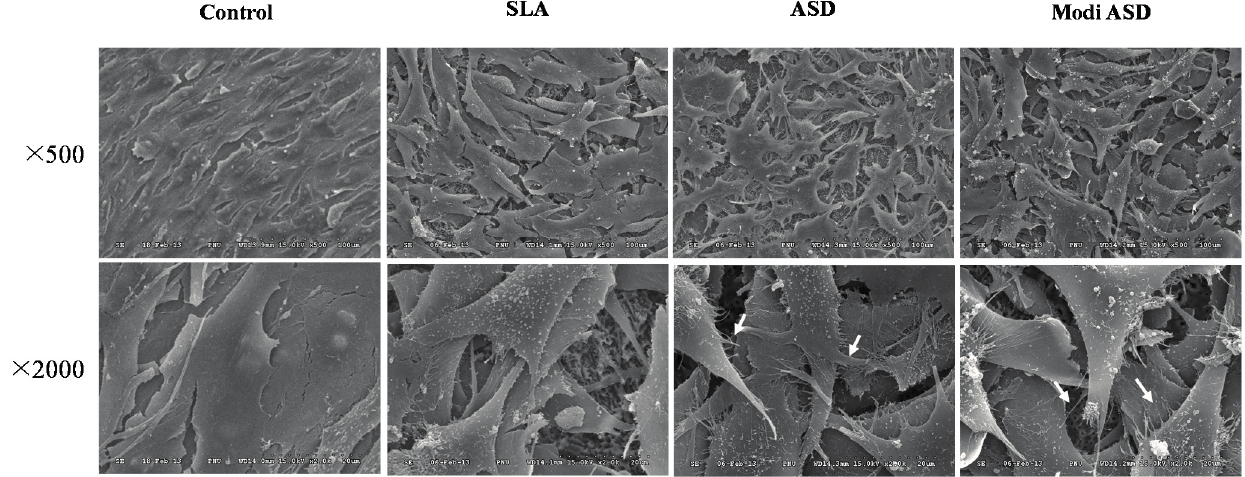
Figure 3. SEM images of the morphologies of MG-63 cells grown on Ti control, SLA, ANO, and Modi-ANO titanium substrates for 24 h.